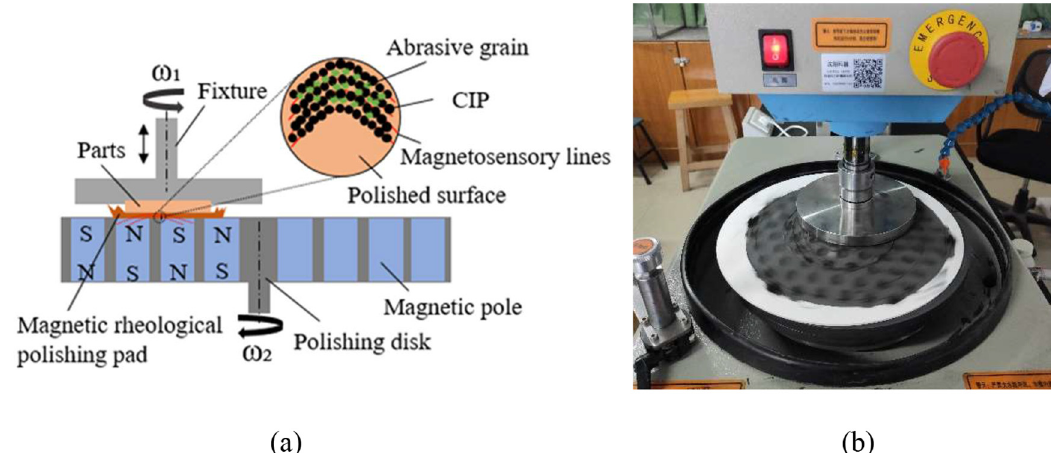
Fig. 1. Principle and equipment of magnetorheological polishing. (a) Polishing principle. (b) Polishing equipment.